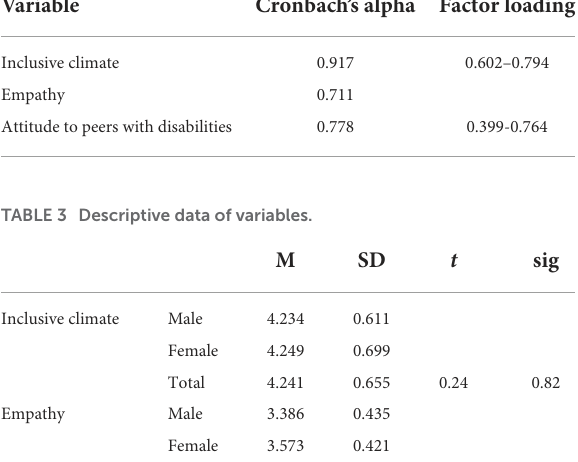
TABLE 2 Questionnaire reliability and factor loading.